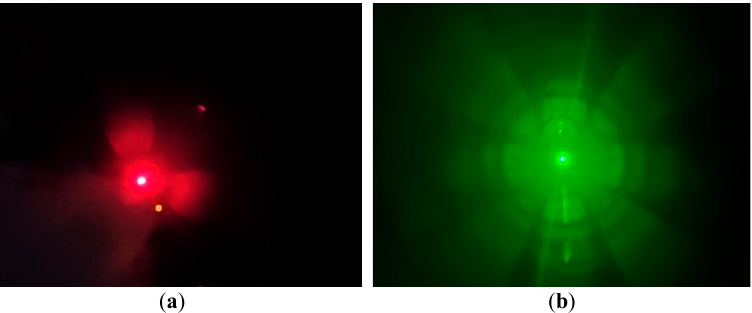
Figure 10. View of the red laser beam from 400 m ( a ) and view of the green laser beam from 1100 m ( b ).